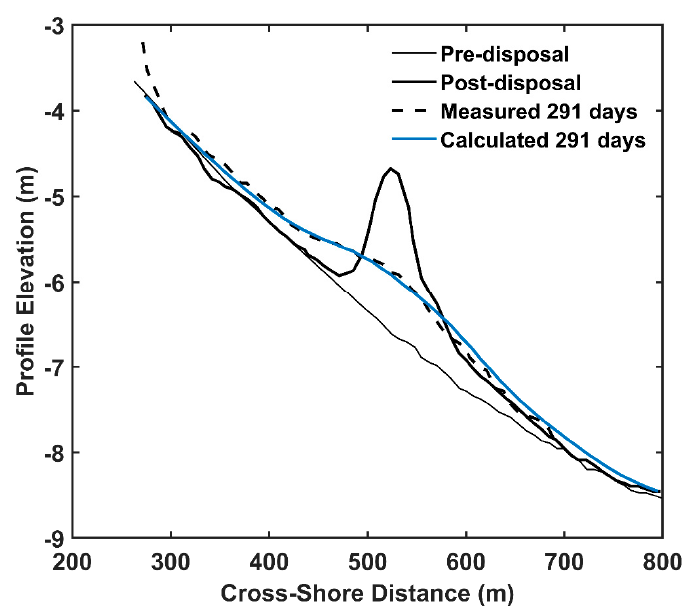
Figure 3. Comparisons between measured and calculated profiles 291 days after the mound placement, Cocoa Beach.